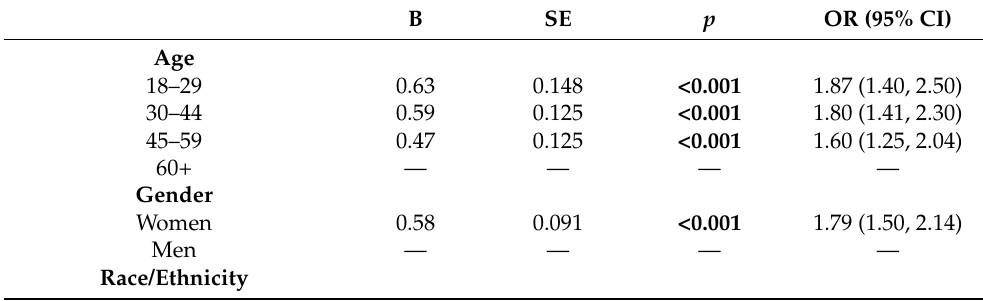
Table 2. Weighted ordinal logistic regression—predictors of general vaccine hesitancy (N =